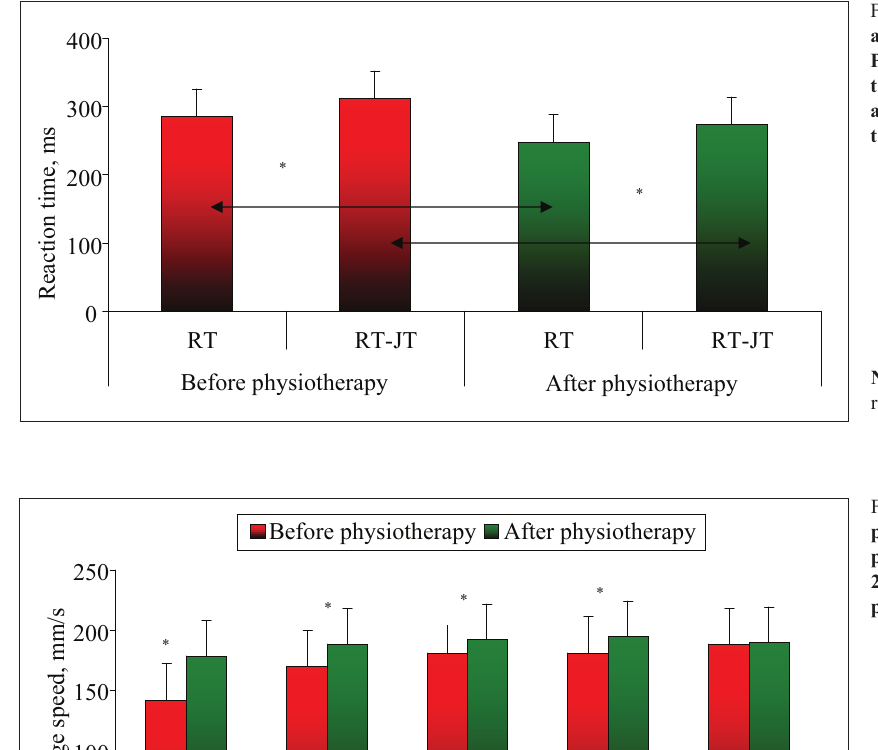
Figure 1. Reaction time (ms) averages in patients with Parkinson’s disease performing a task of 5 sets of 20 repetitions before